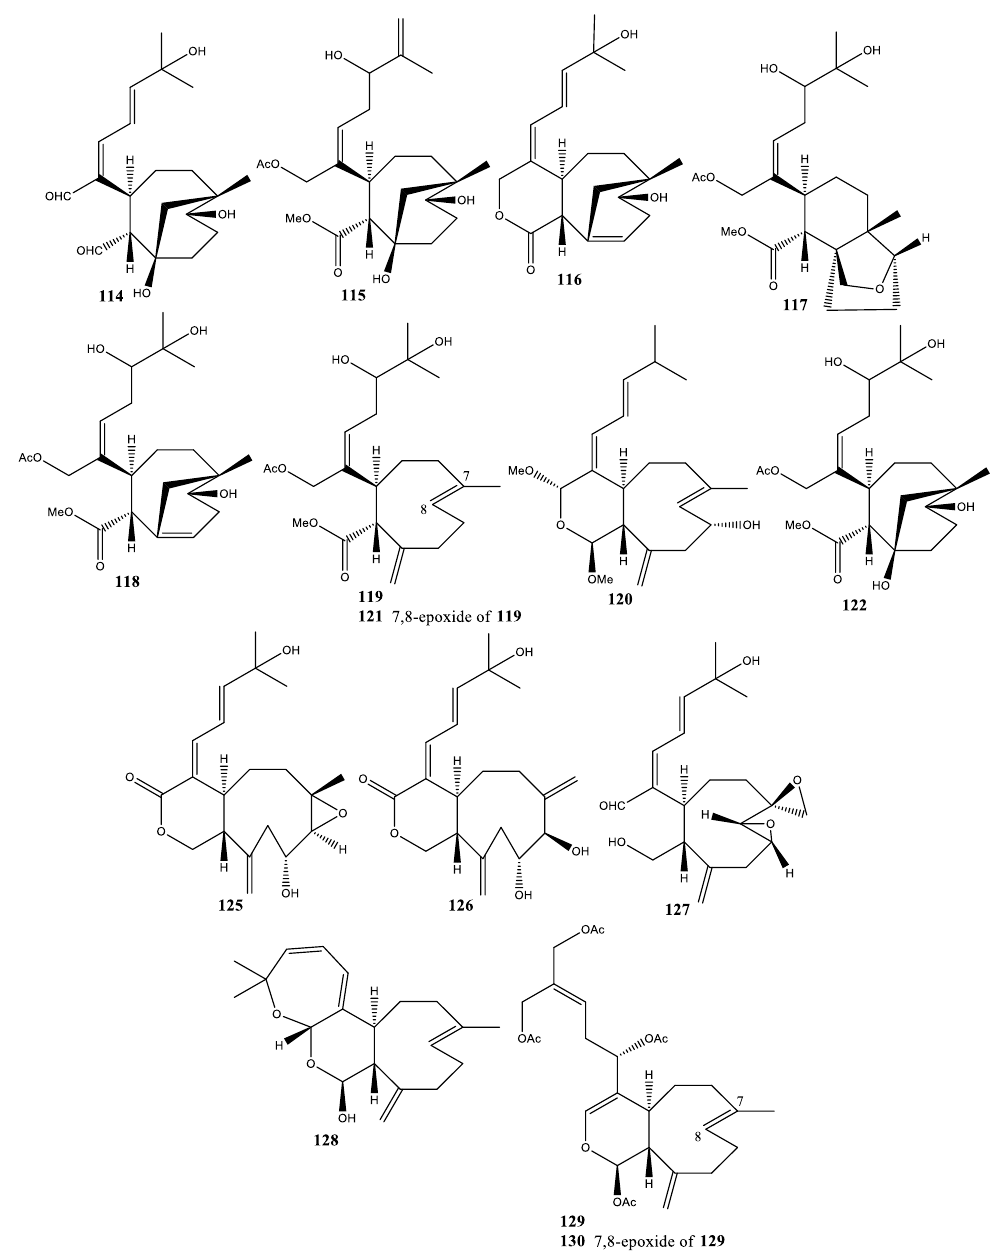
Figure 7. Structures of compounds 114 – 122 and 125 – 130 .